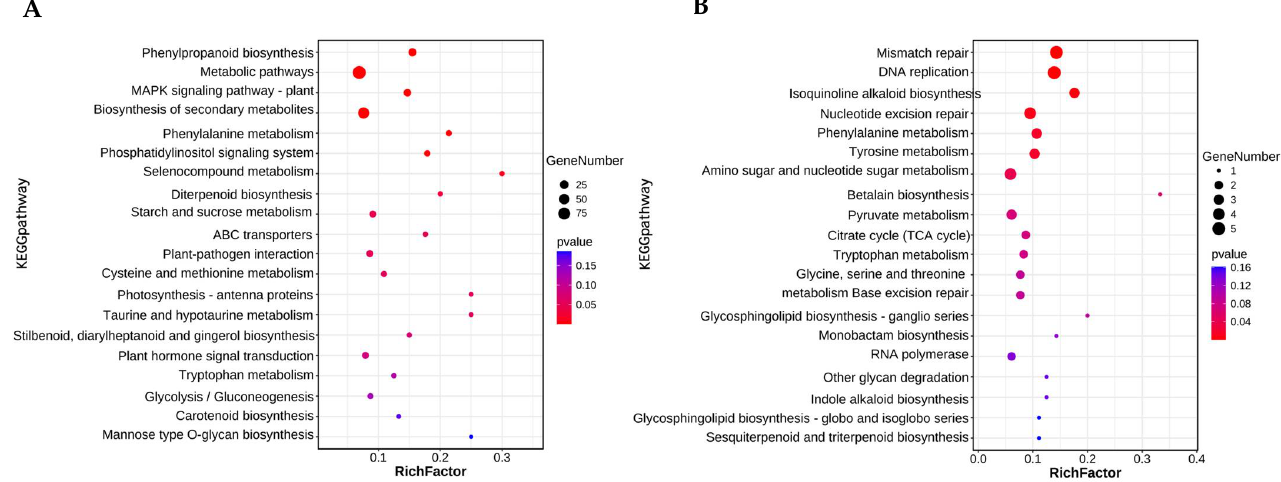
Figure 5. Top 20 KEGG pathways enriched by downregulated DEGs in dwarf samples ( A ), and top 20 KEGG pathway terms enriched by upregulated DEGs in dwarf samples ( B ). Among them, different colors represent the size of the p -value, and the circular size represents the number of enriched.